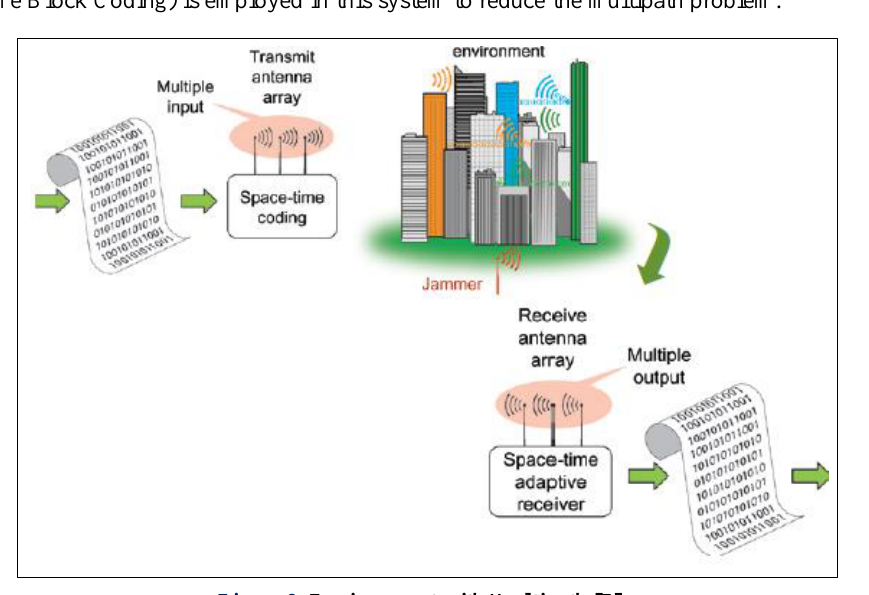
Figure 2. Environment with Multipath